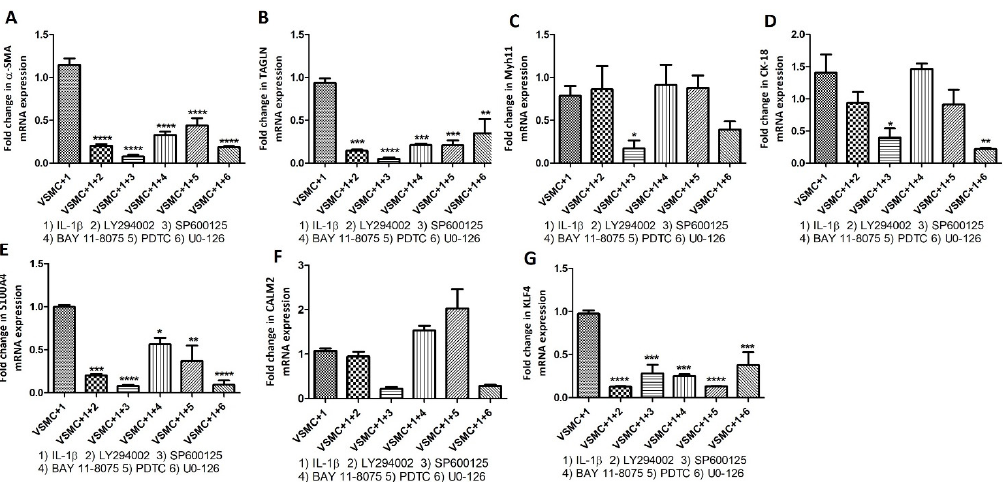
Figure 8. RT-qPCR to investigate the effect of IL-1 β on VSMCs phenotype markers after inhibiting cytoplasmic kinases. RT-PCR data for alpha-smooth muscle actin ( α -SMA; panel A ), transgelin (TAGLN; panel B ), Myosin Heavy Chain 11 smooth muscle (Myh11; panel C ), cytokeratin 18 (CK-18; panel D ), S100 protein A4 (S100A4; panel E ), calmodulin 2 (CALM2; panel F ), and Krüppel-like factor 4 (KLF4; panel G ). α -SMA, TAGLN, and Myh11 (markers for contractile vascular smooth muscle cells (VSMCs)); CK-18, S100A4, and CALM2 (markers for proliferative VSMCs); and KLF4 (marker for de-differentiated VSMCs). Interleukin (IL)-1 β , LY294002 (PI3K inhibitor), SP600125 (JNK inhibitor), BAY 118075 (NF- κ B inhibitor), PDTC (NF- κ B inhibitor), and UO-126 (ERK inhibitor). All data are presented as mean ± standard deviation (SD). p < 0.05 is considered statistically significant. * p < 0.05, ** p < 0.01, *** p < 0.001, and **** p < 0.0001.